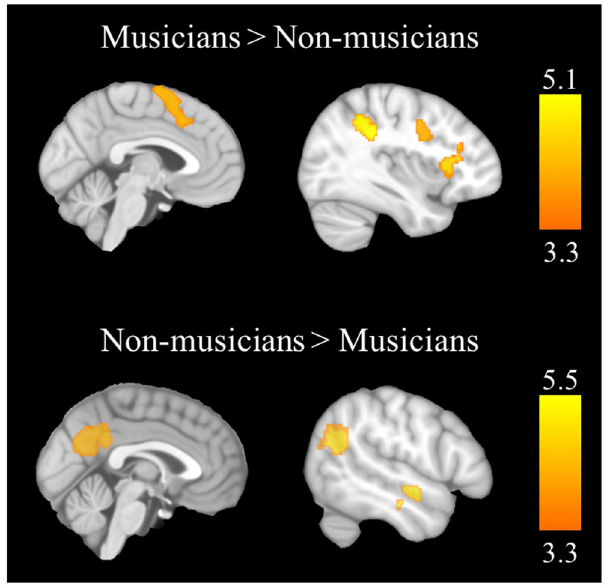
Figure 1. Brain regions showing significant between-group differences in the “Improvise > Reproduce” contrast. The colour bars and clusters indicate t-values.